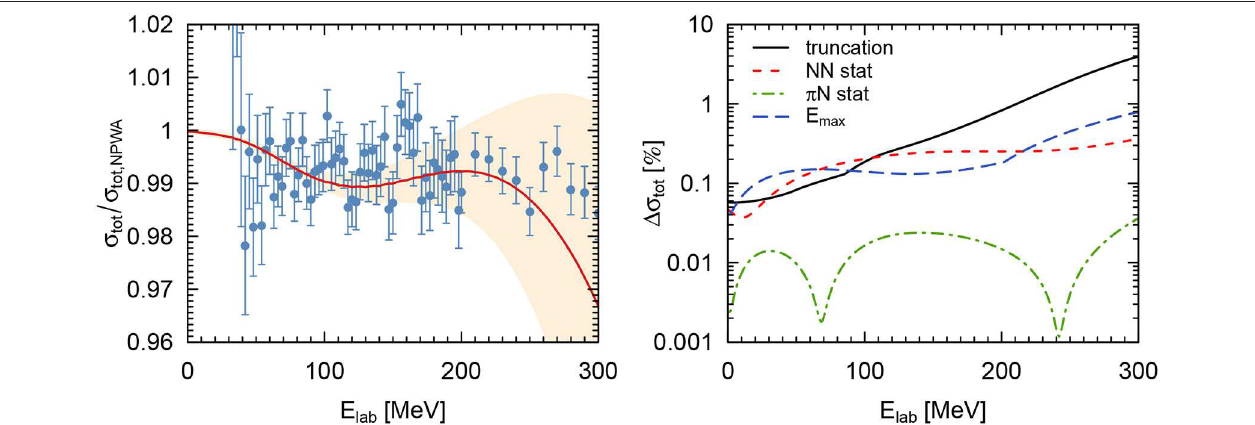
FIGURE 9 | Neutron-proton total cross section in the range of E lab PWA. The red line and peach-colored band show the central values and truncation errors (the 68% DoB interval) at the order N 4 LO + and for 3 experimental data are taken from Lisowski et al. [156] and have been corrected for their estimated norm of 0.999. The plot on the right shows the relative uncertainties as discussed in the text.